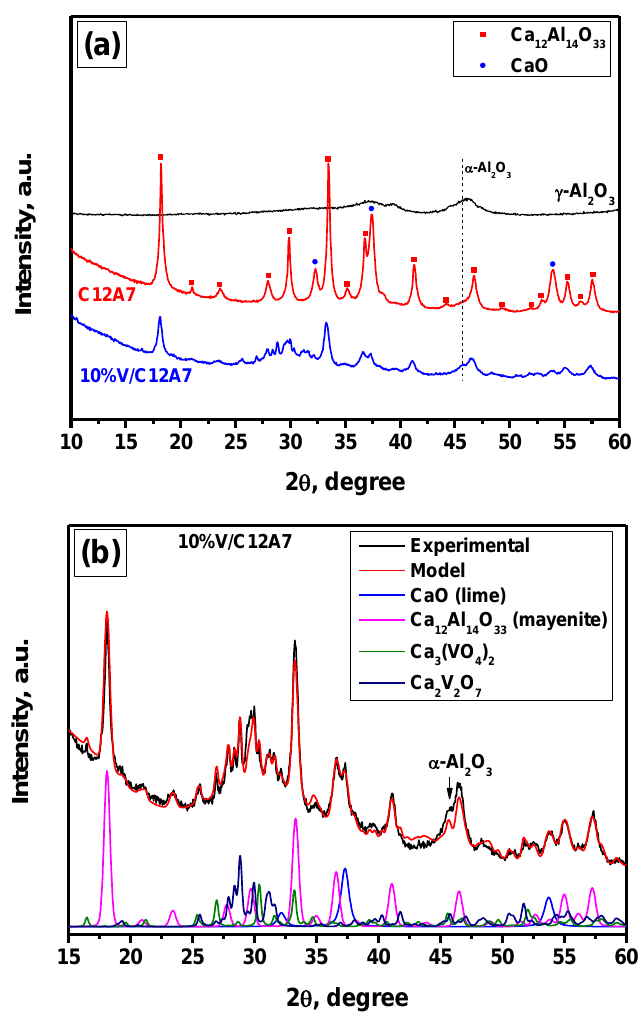
Figure 4. Powder XRD patterns of C12A7 and 10%V/C12A7 samples ( a ); XRD analysis of 10%V/C12A7 sample ( b ).